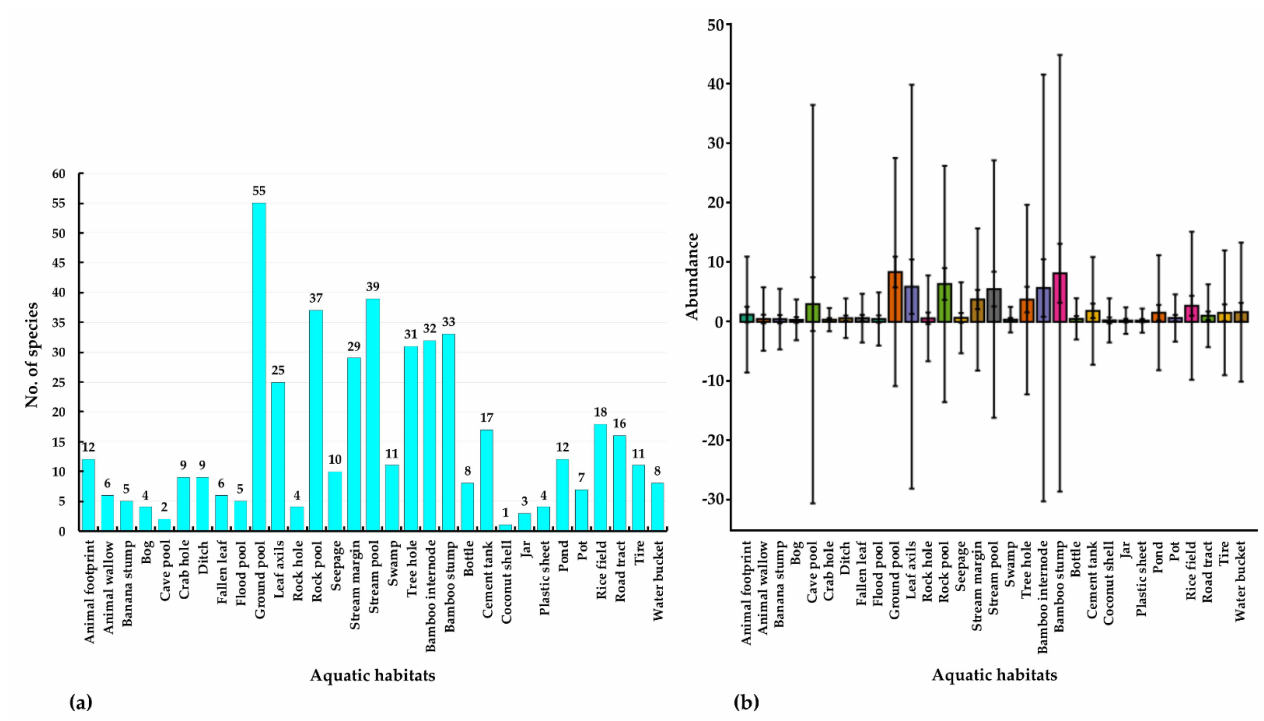
Figure 10. ( a ) Number of species, and ( b ) abundance in aquatic